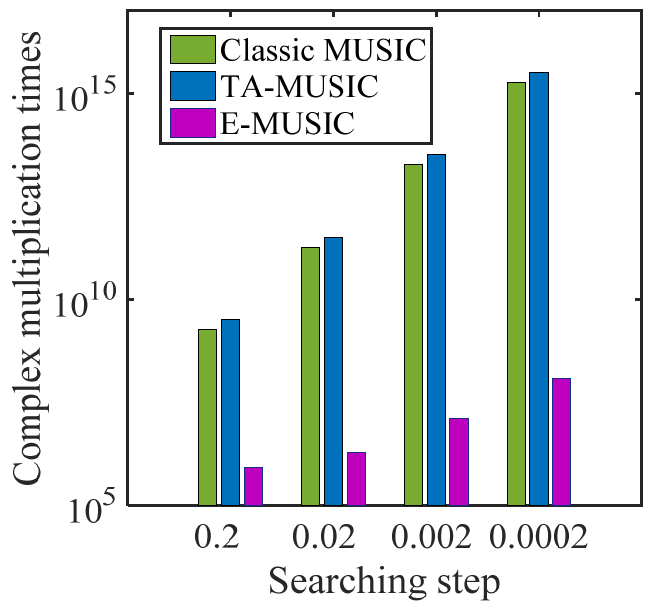
Figure 3. Algorithm complexityaccording to number of snapshots.